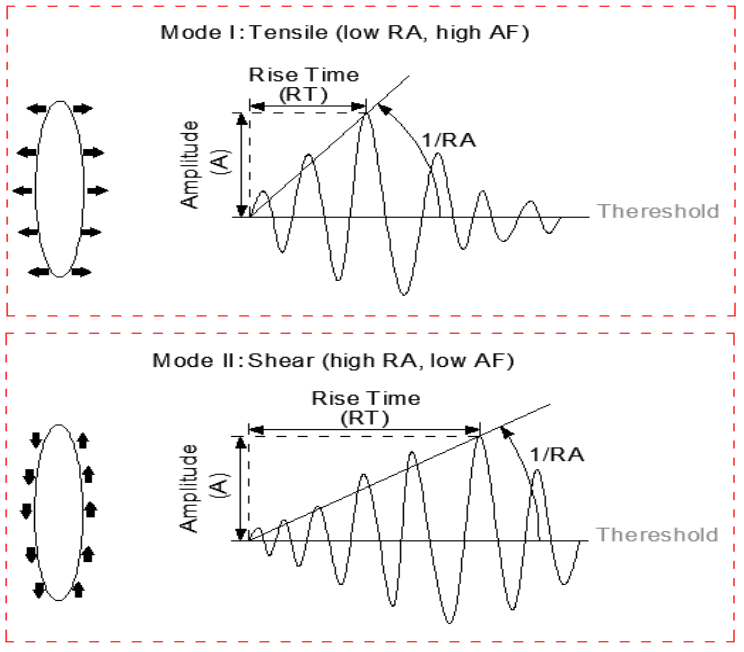
Figure 7. Typical fracture modes and corresponding AE waveforms.